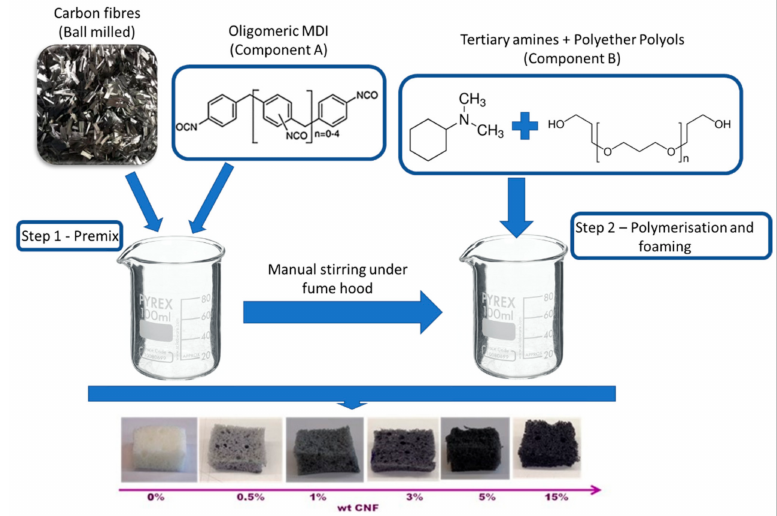
Figure 1. Synthetic route of polyurethane foams loaded with carbon fibers.